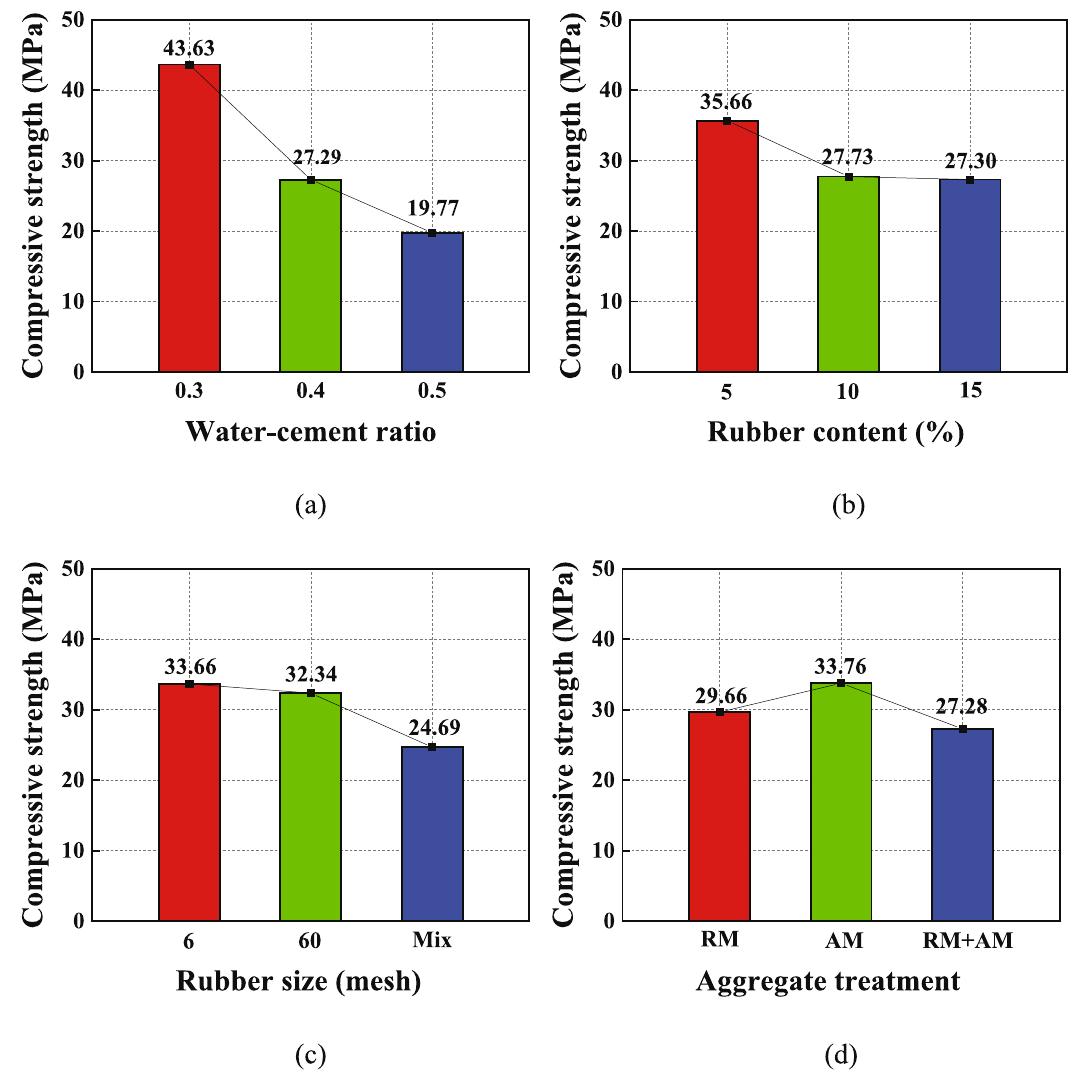
Figure 17: E ff ects of orthogonal factors on compressive strength of RRAC. ( a ) Water – cement ratio, ( b ) rubber content, ( c ) rubber particle size, and ( d ) treatment